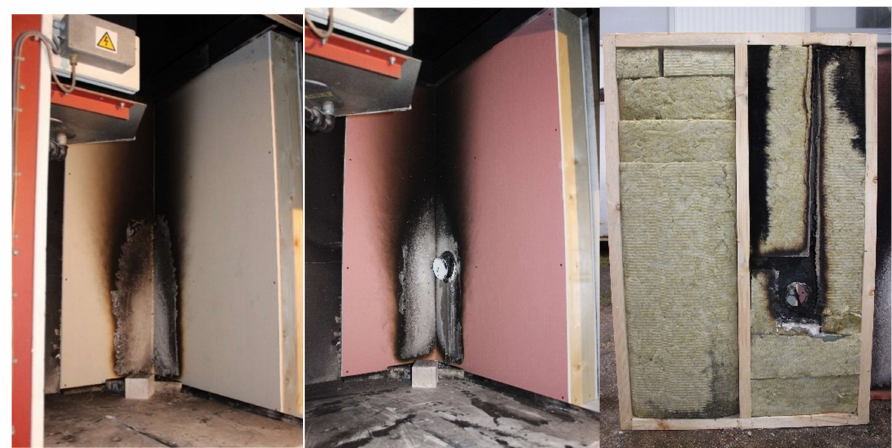
Figure 10. Example of fire testing of whole wall assembly.